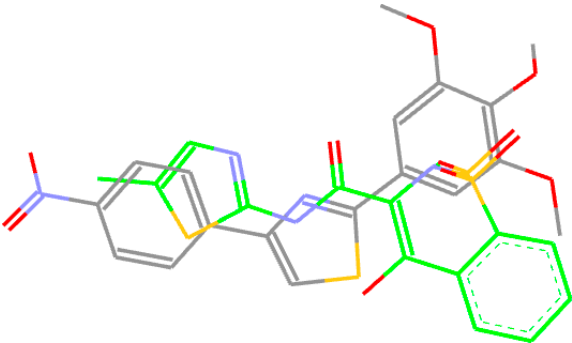
Figure 5. Overlay of MXM (carbon shown in green) and docked pose of A3 (carbon depicted in grey).